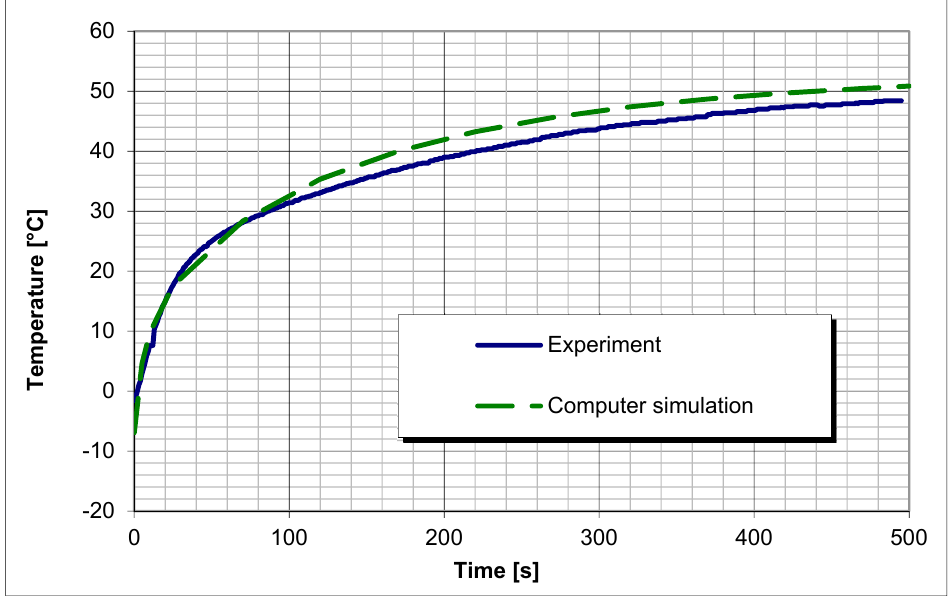
Figure 19. Temperature changes in the motor body close to heat source during start-up of M1 satellite motor obtained from the experimental test and computer simulation (initial motor temperature − 4 °C, oil temperature 54 °C, rotational speed in steady-state conditions 185 rpm). The rotor temperature obtained from the computer simulation is slightly higher than the temperature obtained from the experimental tests (Figure 20). This is due to the fact that the heat transfer occurs from the rotor to the shaft, which was not taken into account in the computer simulation.